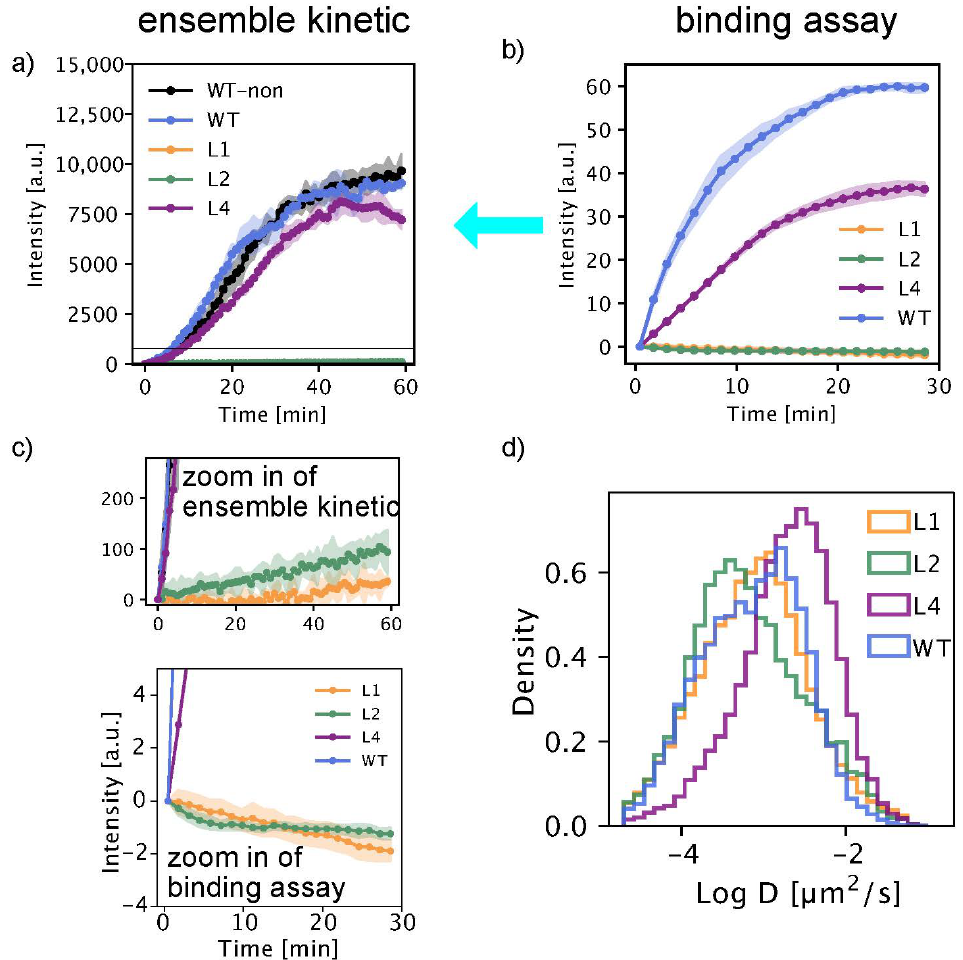
Figure 2. ( a ) Ensemble activity of WT and TLL variants in the detergency application system. ( b ) Binding assay of WT and TLL variants in the detergency application system. ( c ) Top: zoom in on the ensemble activity data in ( a ). Bottom: zoom in on the binding data in ( b ). The negative binding values of L1 and L2 are due to the first surface binding intensity being set to zero. ( d ) Quantification of the mobility of individual lipase types on lard surfaces in the application system. Histogram plots of the distribution of lipase as the logarithm of the diffusion coefficients (log D) across the four types of